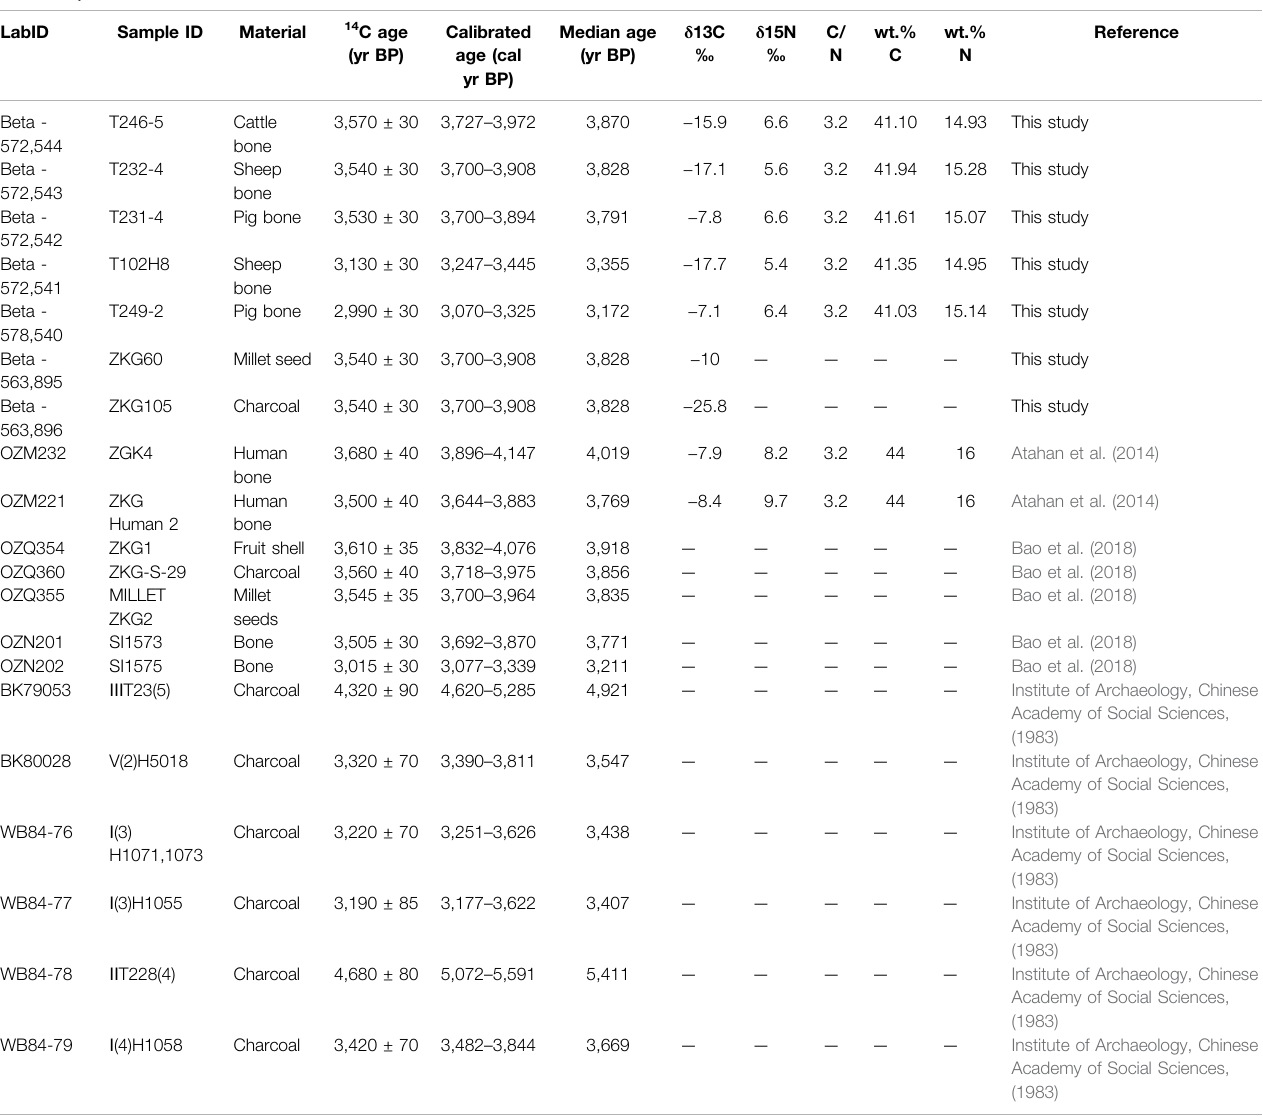
TABLE 2 | 14 C dates for the ZGK